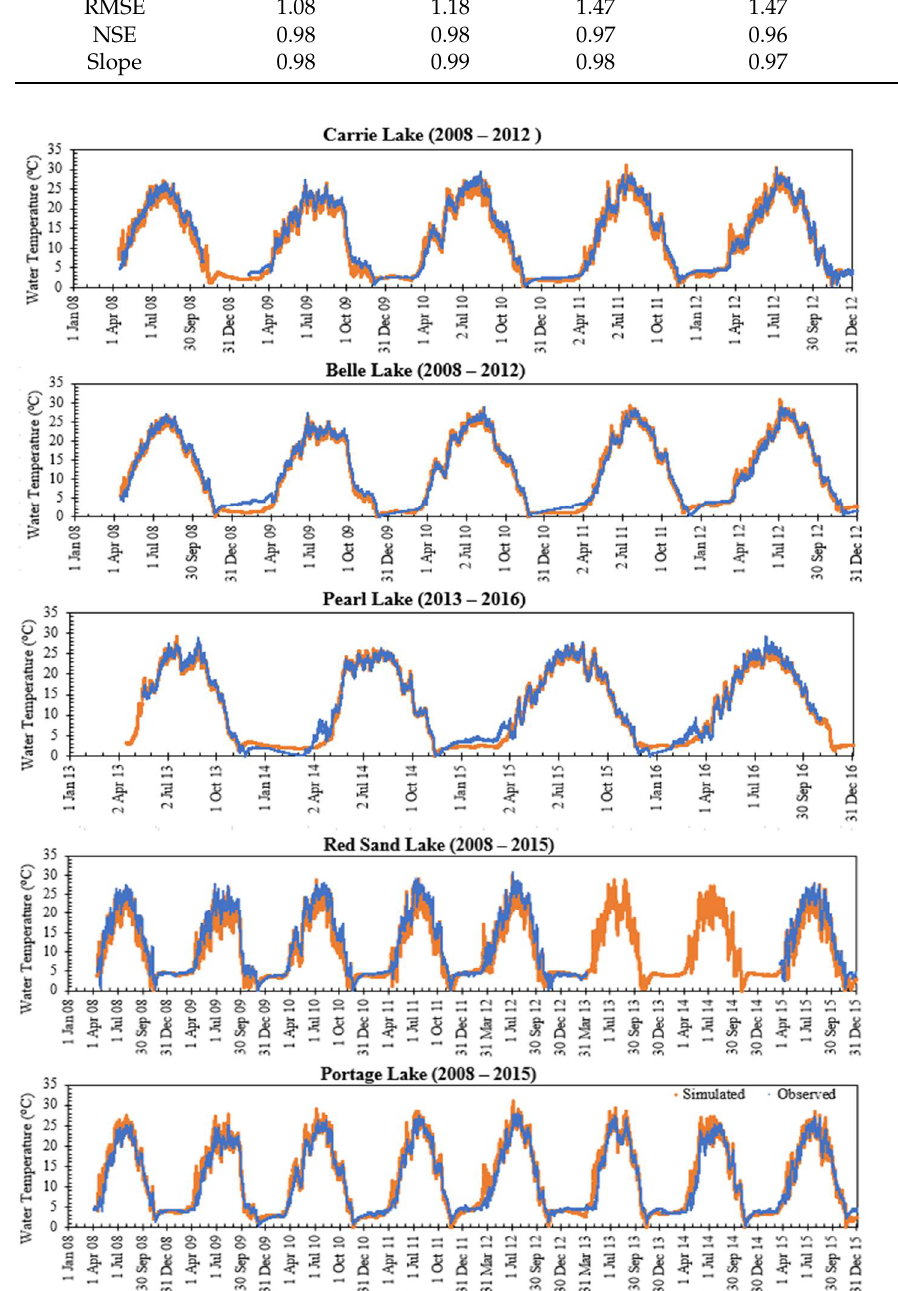
Figure 6. Time series of observed (orange) and simulated (blue) hourly surface water temperatures in five study lakes over 4–8 years of simulation.